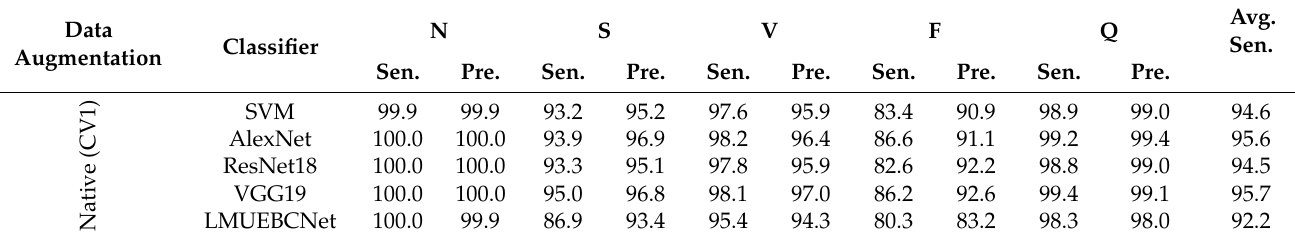
Table A2. Sensitivity/precision of LMUEBCNet with existing models using native/Corr-OS/Next-OS dataset under CV1.